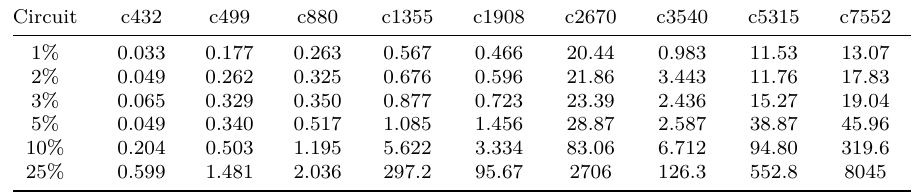
Table 5: Execution Time of SMT Attack in the Lazy Mode (Attack Mode 3) on ISCAS-85 Benchmarks with Different Obfuscation Overhead, Obfuscated using DLL[XS17]+RLL[RKM10] (50%-50%).